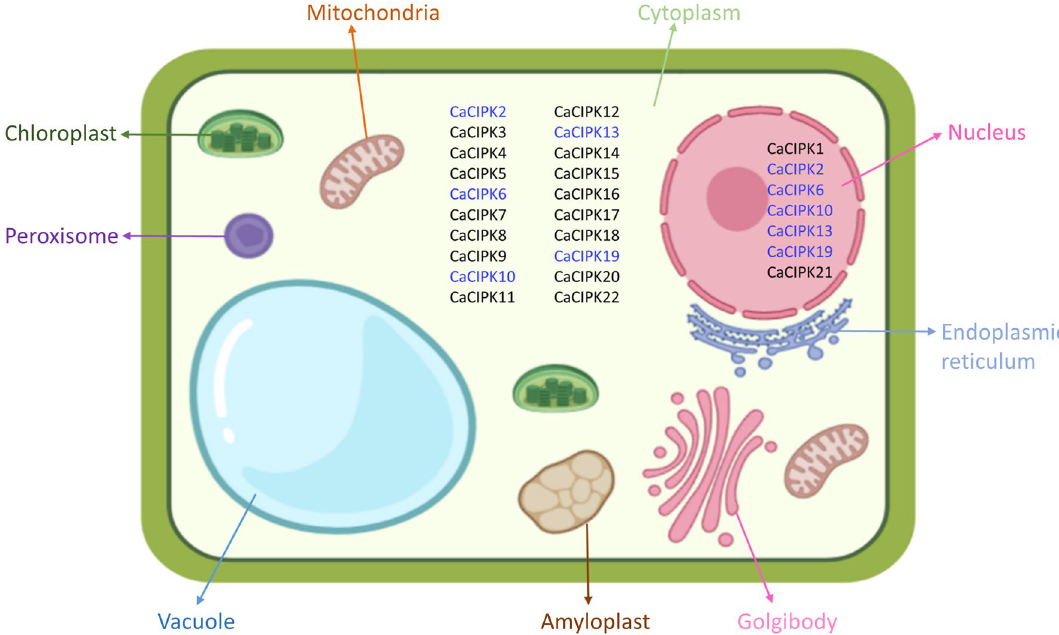
Figure 5. Subcellular localization of chickpea CIPK proteins. Localization was predicted using the CELLO program. Genes located in both cytoplasm and nuclei are indicated by blue